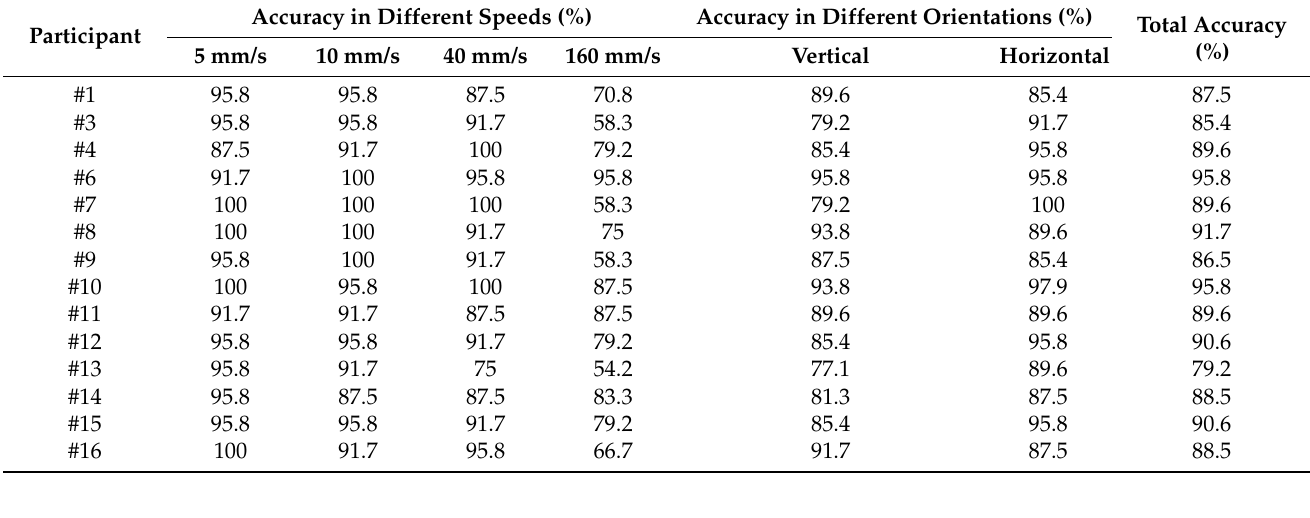
Table 3. Accuracy of the testing session.